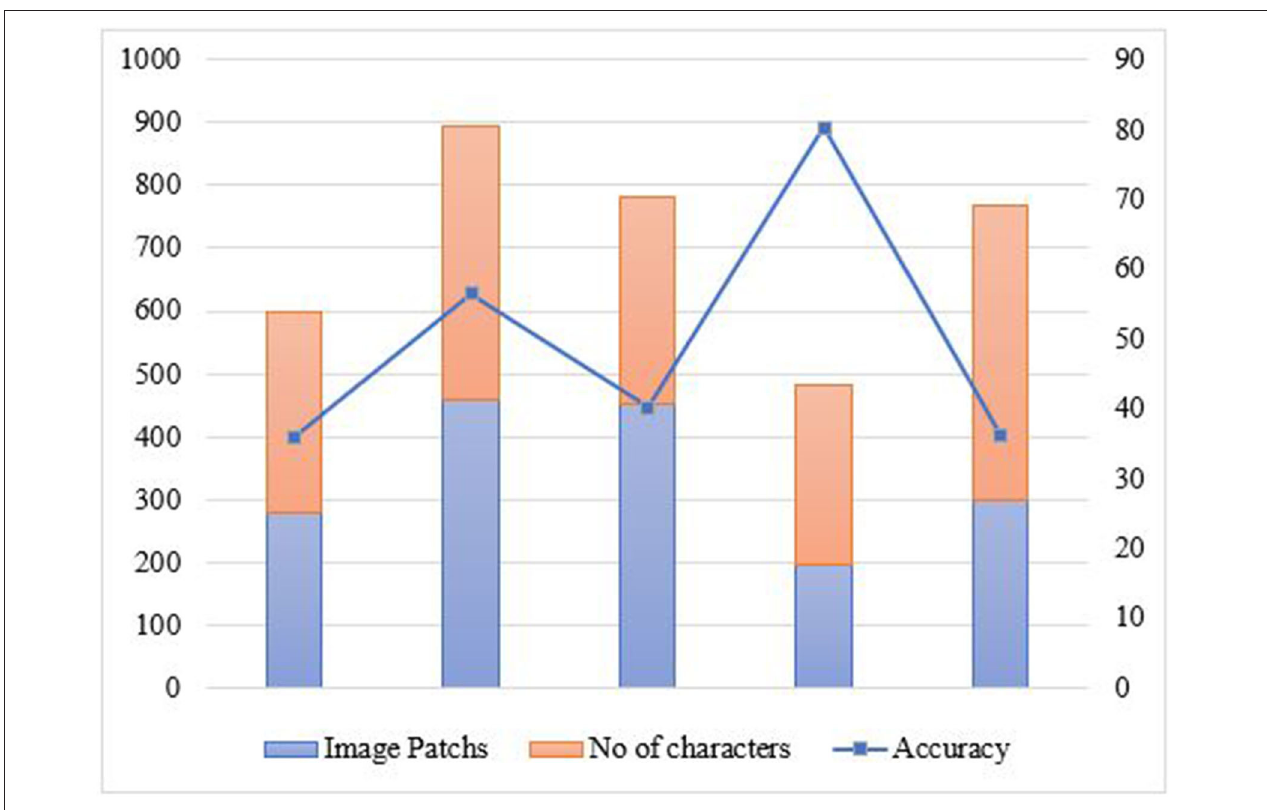
FIGURE 7 | Performance accuracy for corresponding image